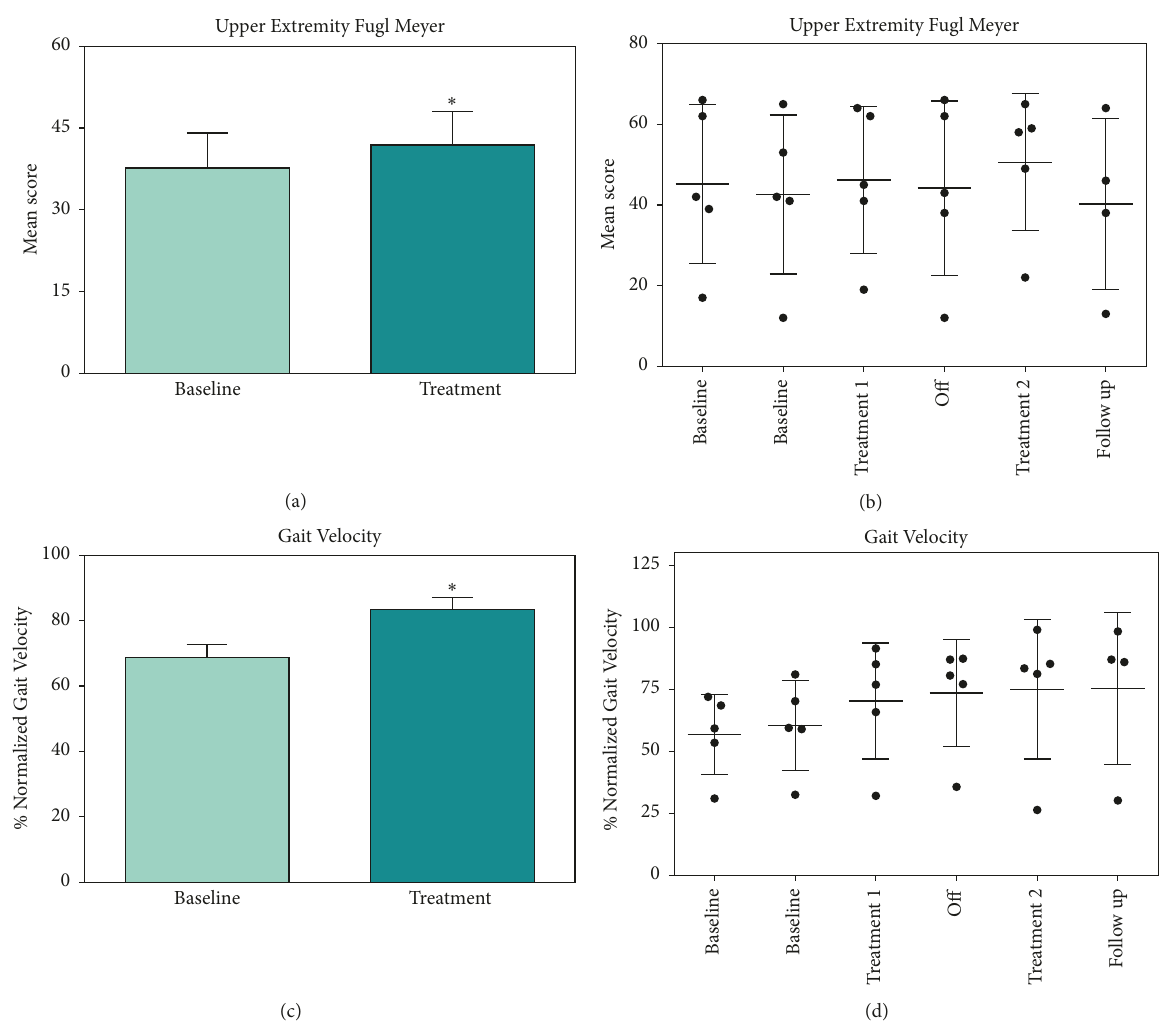
Figure 2: Effect of HBOT on Gait and UE mobility: we observed significant improvement in physical abilities as measured with the Upper Extremity Fugl Meyer (UEFM, (a & b) and gait velocity (c & d). Graphs (a) and (c) represent the difference between baseline and treatment and (b) and (d) show all individual data